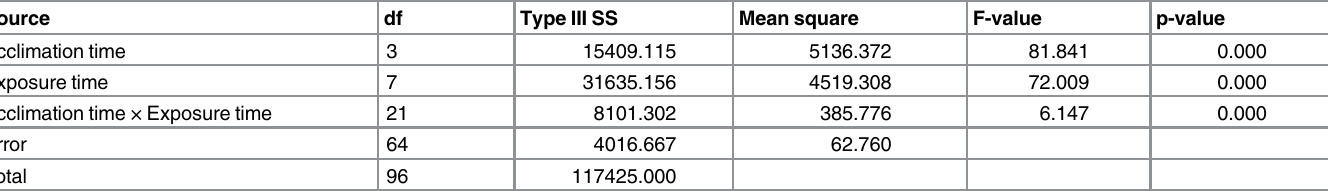
Table 2. Two way analysis of variance (ANOVA) parameters for main effects and associated interactions for the mortality of S . zeamais exposed to 43°C.